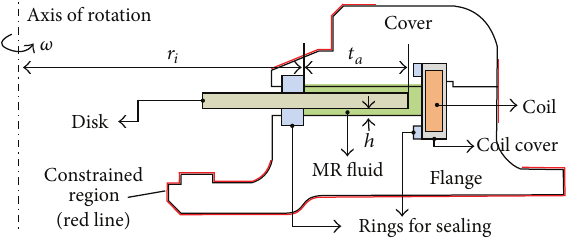
Figure 2: Cross-section of the rotary MR damper.